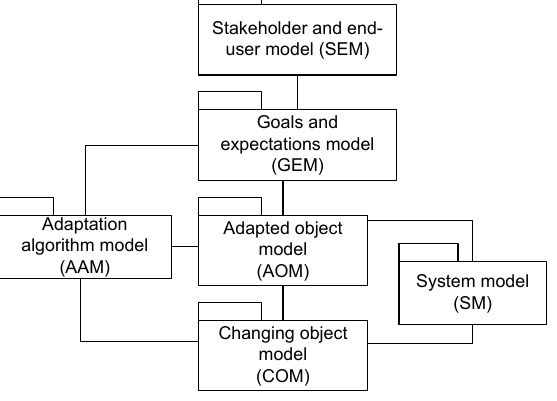
Figure 4. The model of the user adaptive enterprise application – a high level abstraction